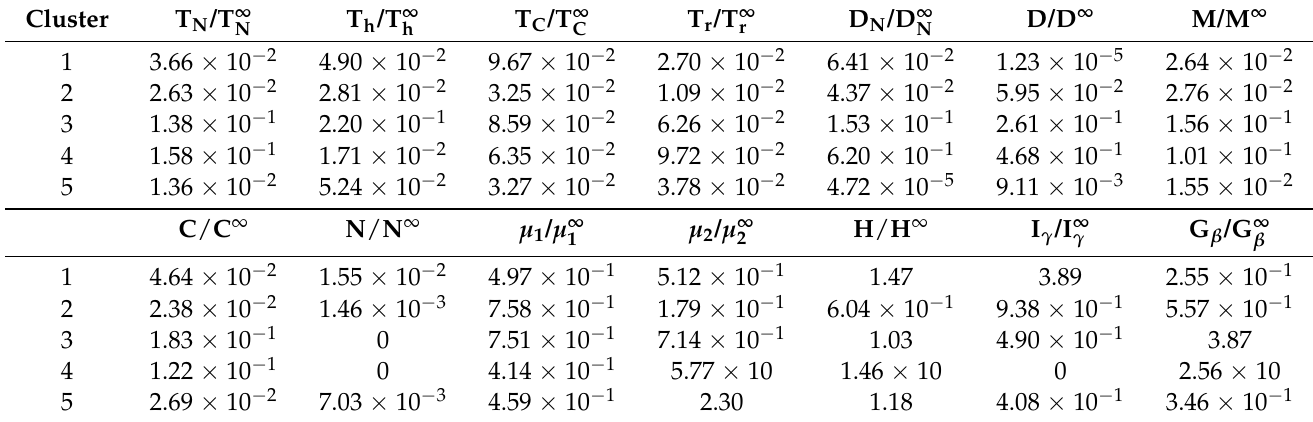
Table 2. The smallest tumor initial conditions in each cluster. Values of initial conditions for the dimensionless system are derived from the patients with the smallest tumor size.